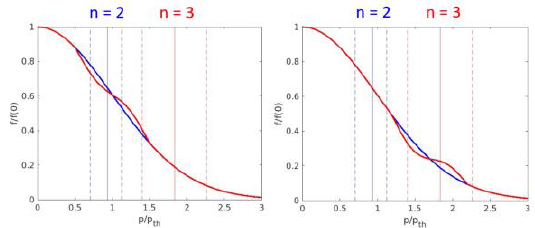
Fig. 4. Model electron momentum distribution function (red) compared to the Maxwellian (blue), both normalised to the value at p=0. The vertical lines define the ranges seen by ECE at the 2 nd and 3 rd harmonics, for T e =7 keV. Examples of perturbations mainly affecting the 2 nd (left) and the 3 rd (right) harmonics.